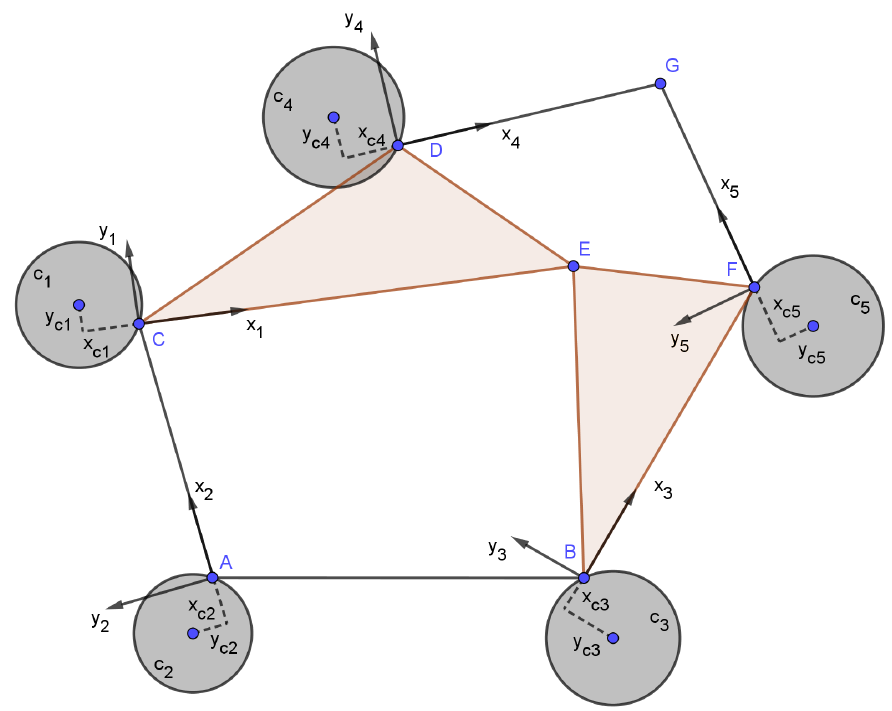
Figure 3. Six-bar mechanism with cylindrical